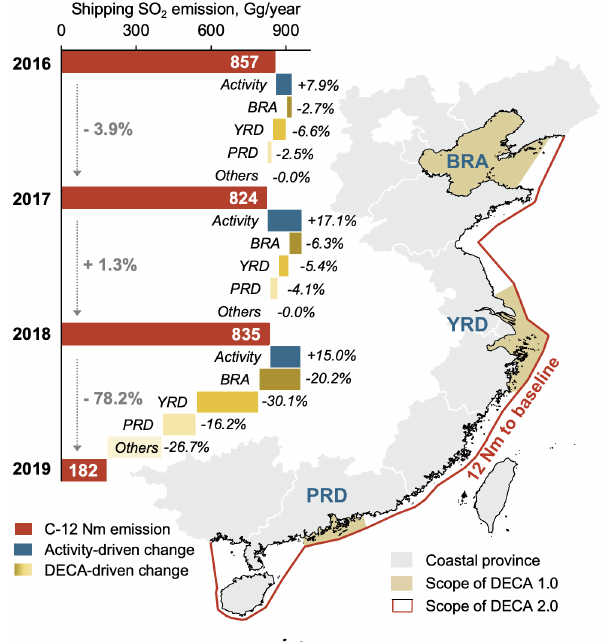
Figure 14. Regional contributions to annual reduction in SO 2 emis- sions from ships within 12Nm of the baseline of China’s territorial sea. The figures inside the blue bars refer to the annual emissions. The percentages refer to the relative change in emissions due to to- tal ship activity change in the C-12Nm region or the DECA policies in each